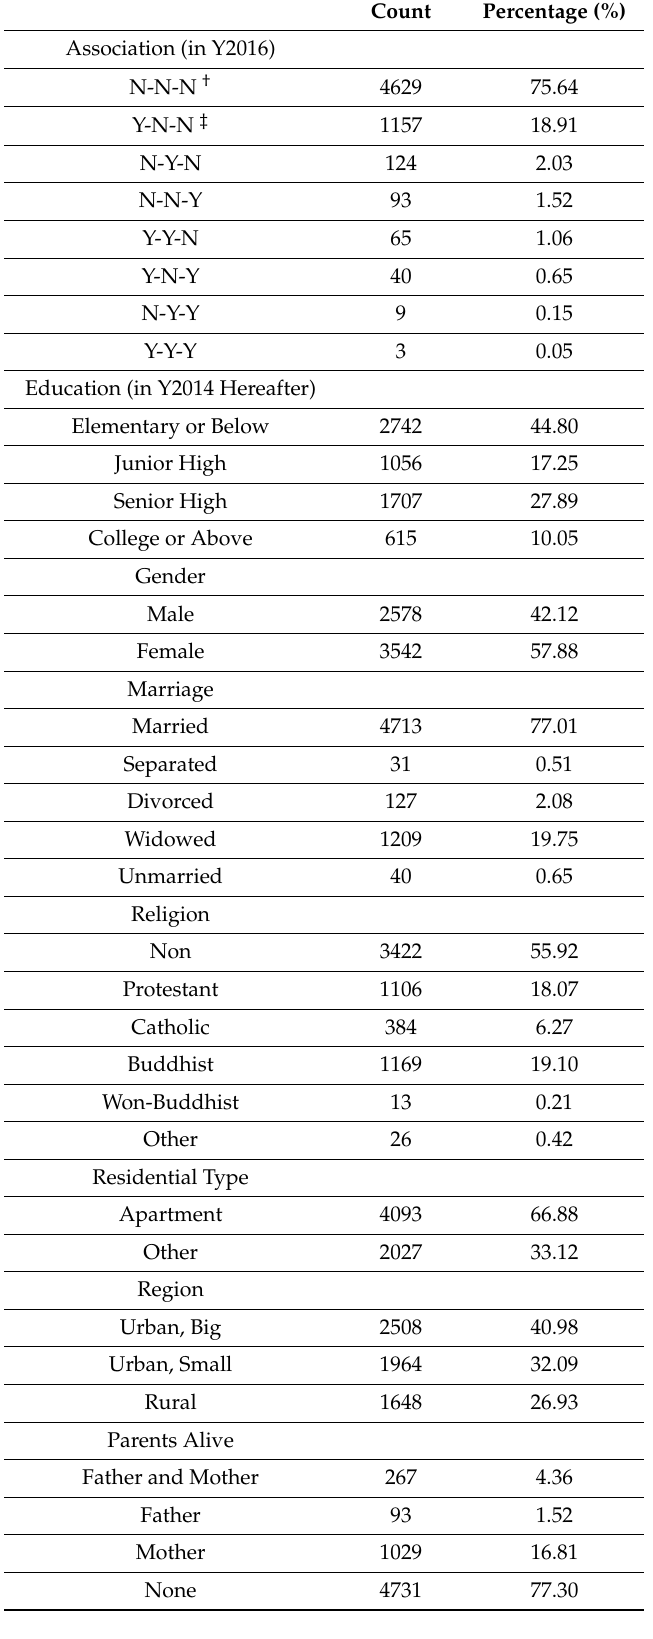
Table 1. The frequency tables for participants’ disease–disease association and categorical